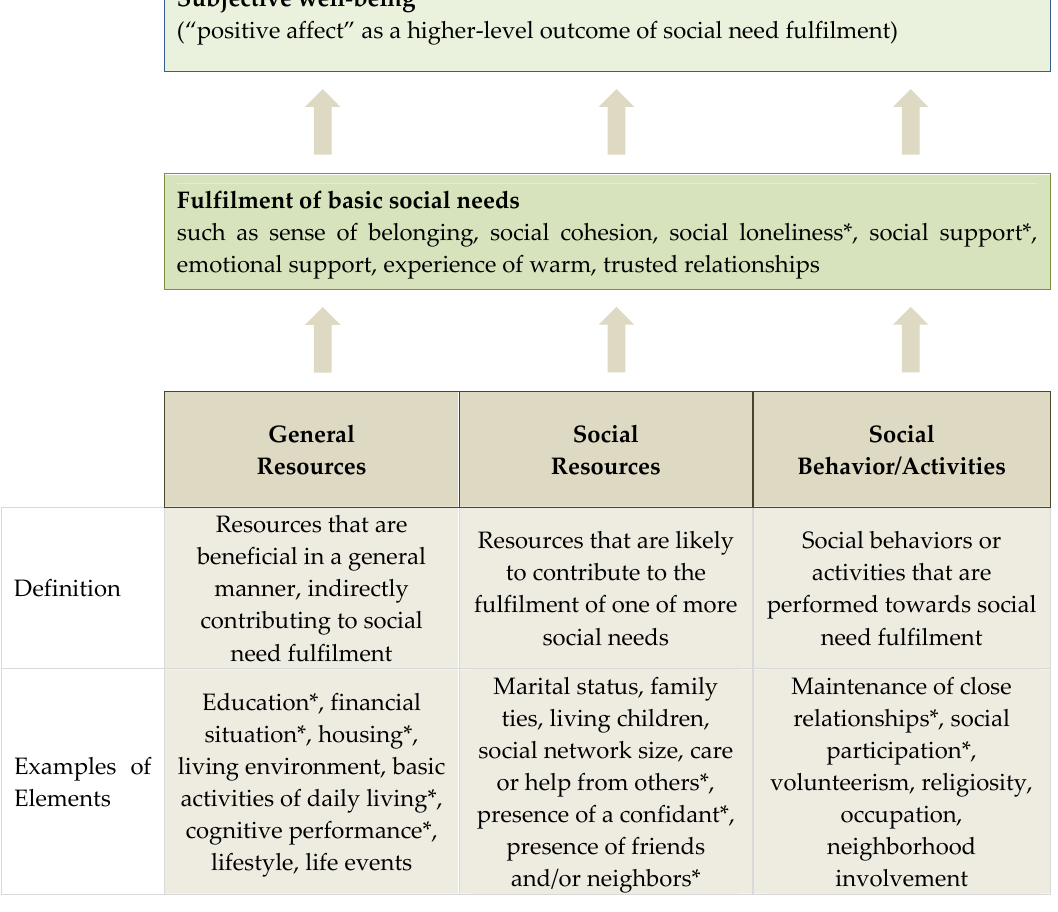
Figure 1. Conceptual model of social frailty proposed by Bunt et al. [5]. This figure, adapted from Bunt’s social frailty concept, shows the categories of ‘general resources’, ‘social resources’, and ‘social behavior/activities’ that lead to the ‘fulfilment of basic social needs’, which in turn lends a positive impact to subjective well-being when needs are met. Examples of elements in the categories are included, some of which are included in this study. * denotes elements included in our analysis.